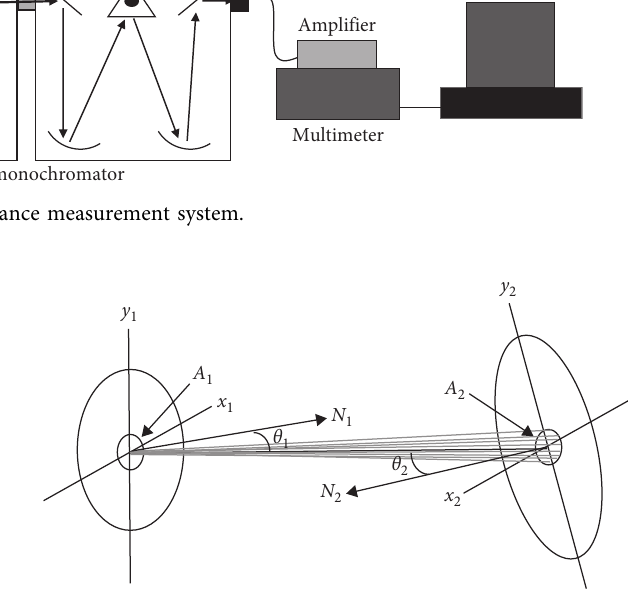
Figure 2: Geometric identification between source and